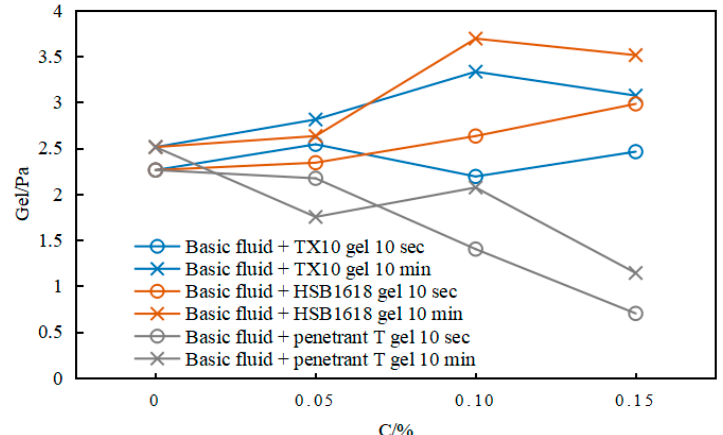
Figure 3. The gel strength of solid-free drilling fluid.